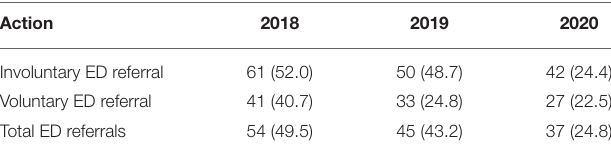
TABLE 5 | Average hospital ED Wait Times (minutes): Voluntary vs. involuntary